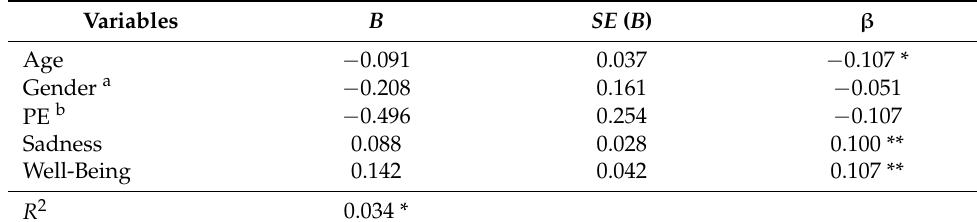
Table 5. Regression results for physical